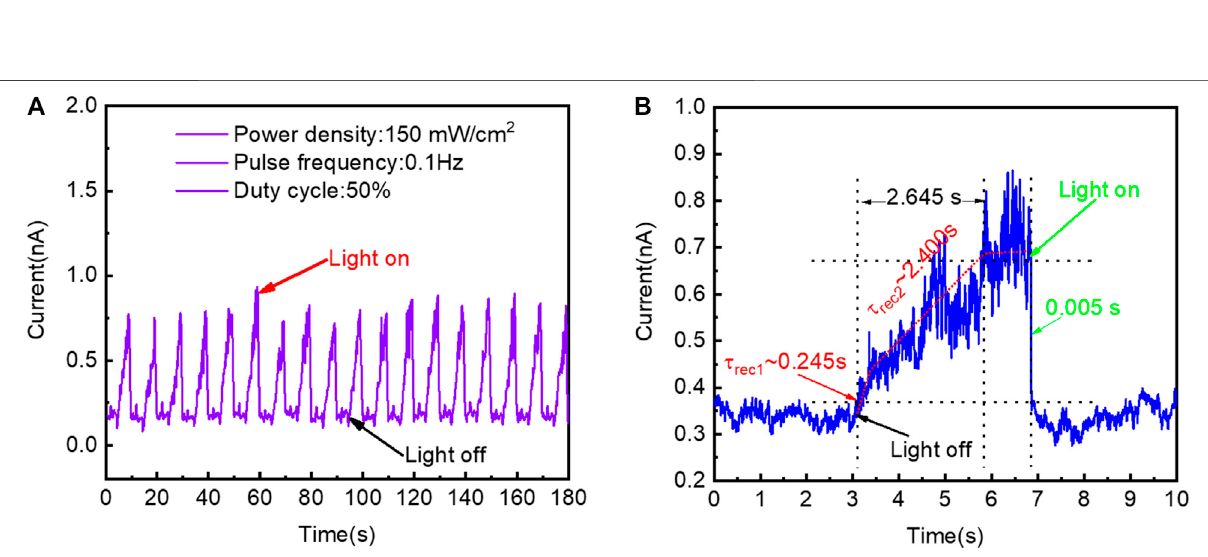
Frontiers in Physics |